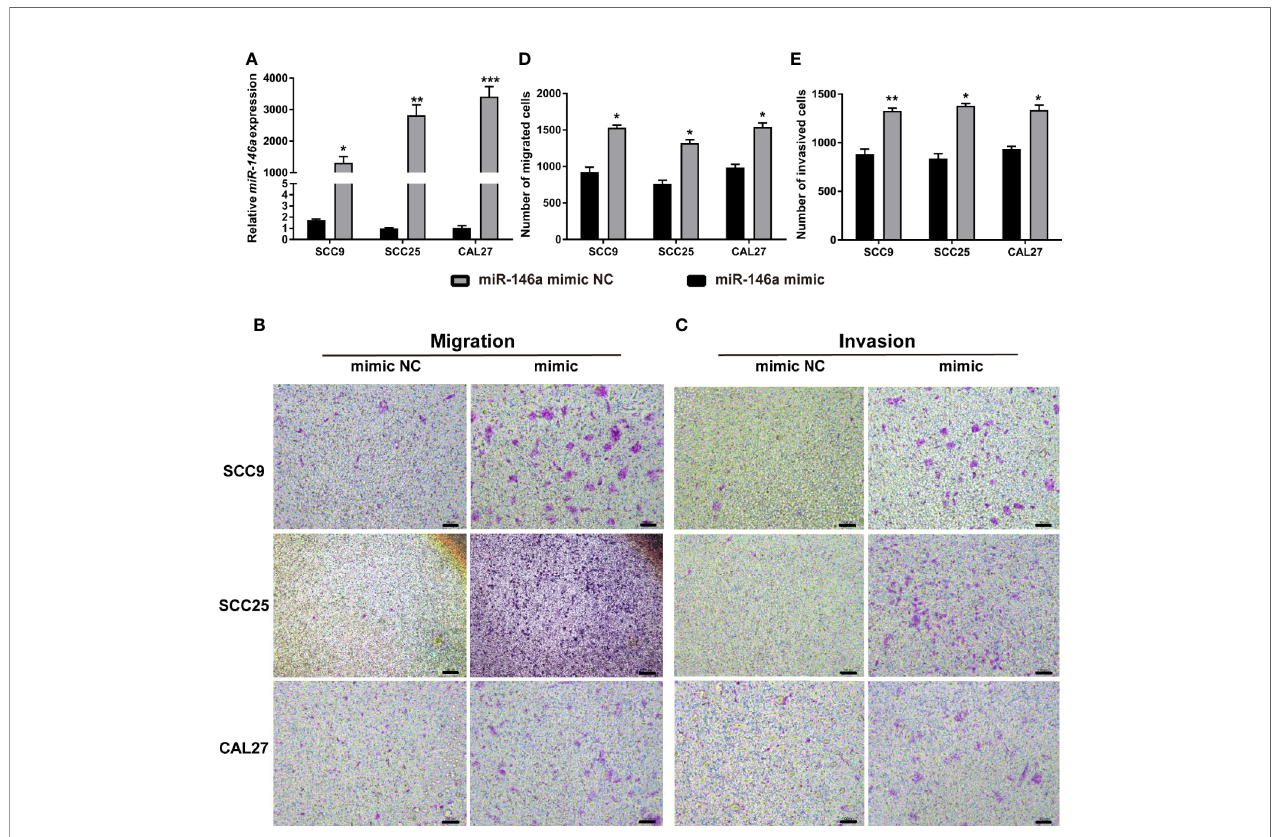
FIGURE 2 | Transfection of miR-146a in OSCC cells enhanced cell migration and invasion. (A) miR-146a expression pattern in OSCC cells transfected with miR- 146a negative mimic control or miR-146a mimic. Representative microscopic images of (B) OSCC cell migration, and (C) OSCC cell invasion assays. Purple dots and patches indicate the migrated and invaded cells. Quantitative analysis of (D) migrated, and (E) invaded cells from fi gure B and C. Data are presented as mean ± SD form three independent experiments in triplicate. Signi fi cant effect of miR-146a transfection, *P < 0.05, **P < 0.01, and ***P < 0.001. NC, negative control. Scale bar, 100 m